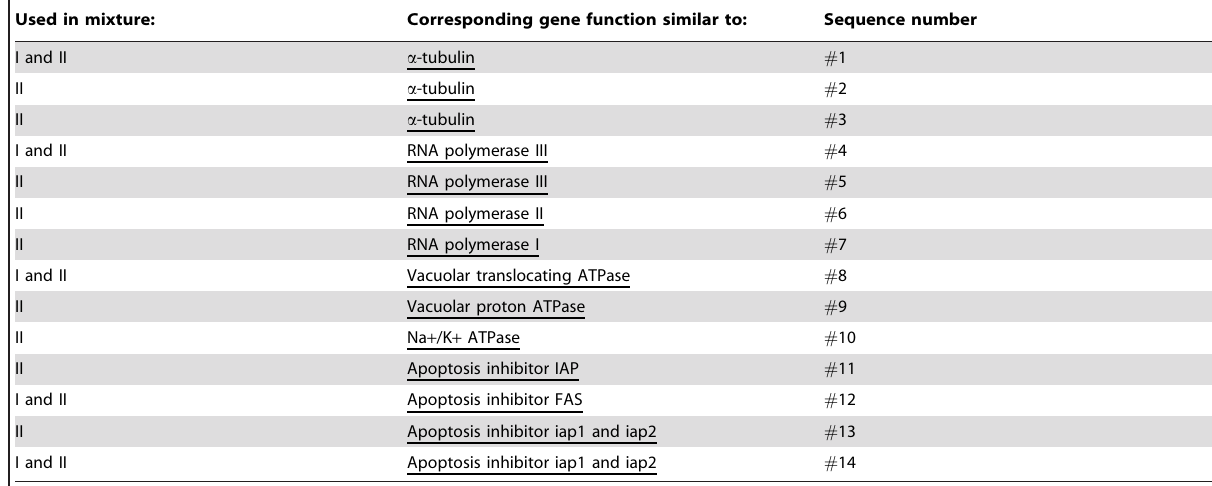
Used in mixture: Corresponding gene function similar to: